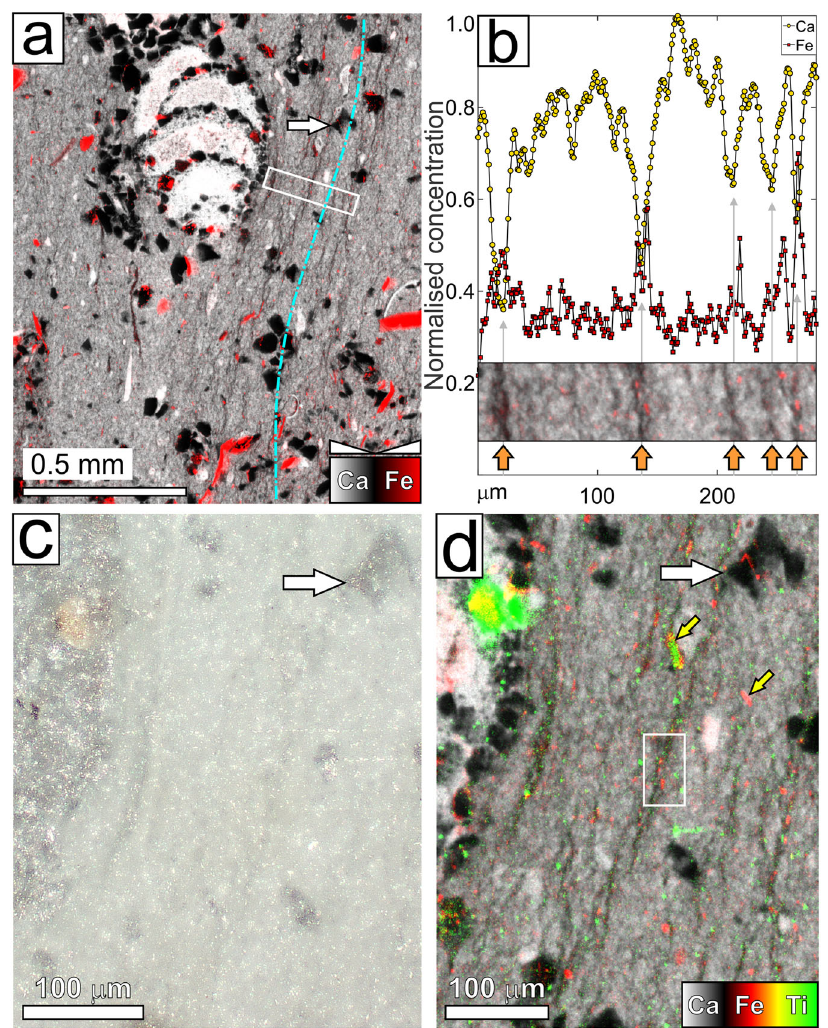
Fig. 4 Micro-dissolution seams in Sample B. a XFM map for a macroscopically stylolite-free wackestone sample of the Kaiwhata limestone displaying Ca (grey scale) and Fe (red scale). Sedimentary bedding is vertical. On the right side of the large fossil in the central top of the image, an array of micro- dissolution seams is visible, similarly marked by Ca depletion and Fe enrichment. The blue dash-dot line shows the averaged seam orientation wrapping around and merging with the bedding orientation below the micro-fossil. The white rectangle marks an area, for which averaged Ca and Fe concentrations pro fi les normal to the dissolution seams have been obtained, shown in ( b ). The Fe pro fi le in b is shifted downwards by 0.3 units for legibility. Ca is depleted by ca. 40% while Fe is enriched by about 67% in the seams. The inset shows a magni fi ed view of the white box in ( a ) where arrows mark the positions of micro-dissolutions seams. Fe-rich phases have elongated ellipsoidal or rectangular shapes aligned with bedding. c Re fl ected-light micrograph of the studied wackestone sample. The white arrow serves as spatial reference to the corresponding three-element XFM map in ( d ). Dissolution seams appear as very faint schlieren in ( c ) but are clearly visible in the micro-chemical map ( d ). Grey colours mark Ca concentrations, red colours correspond to Fe concentrations, and green colours denote Ti concentrations. Ca is depleted in seams (dark-grey colours) while Fe and Ti are enriched. The white rectangle marks an area containing a prominent micro-dissolution seam, for which XFM maps and nano-scale ptychography have been acquired (Fig. 5). The yellow arrows in ( d ) mark two prominent platy Ti- and Fe-rich minerals, which are not visible at the sample surface in ( c ). This observation highlights the important volumetric sampling capacity of XFM. The XFM maps used to make this fi gure are provided in Supplementary Data 2 and